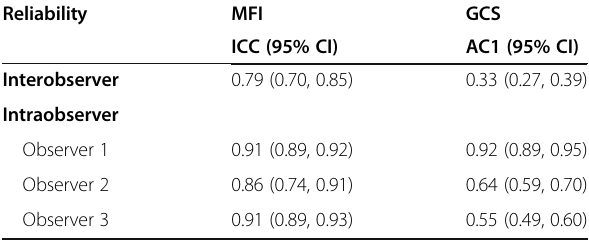
Table 4 Interobserver and intraobserver reliability Reliability